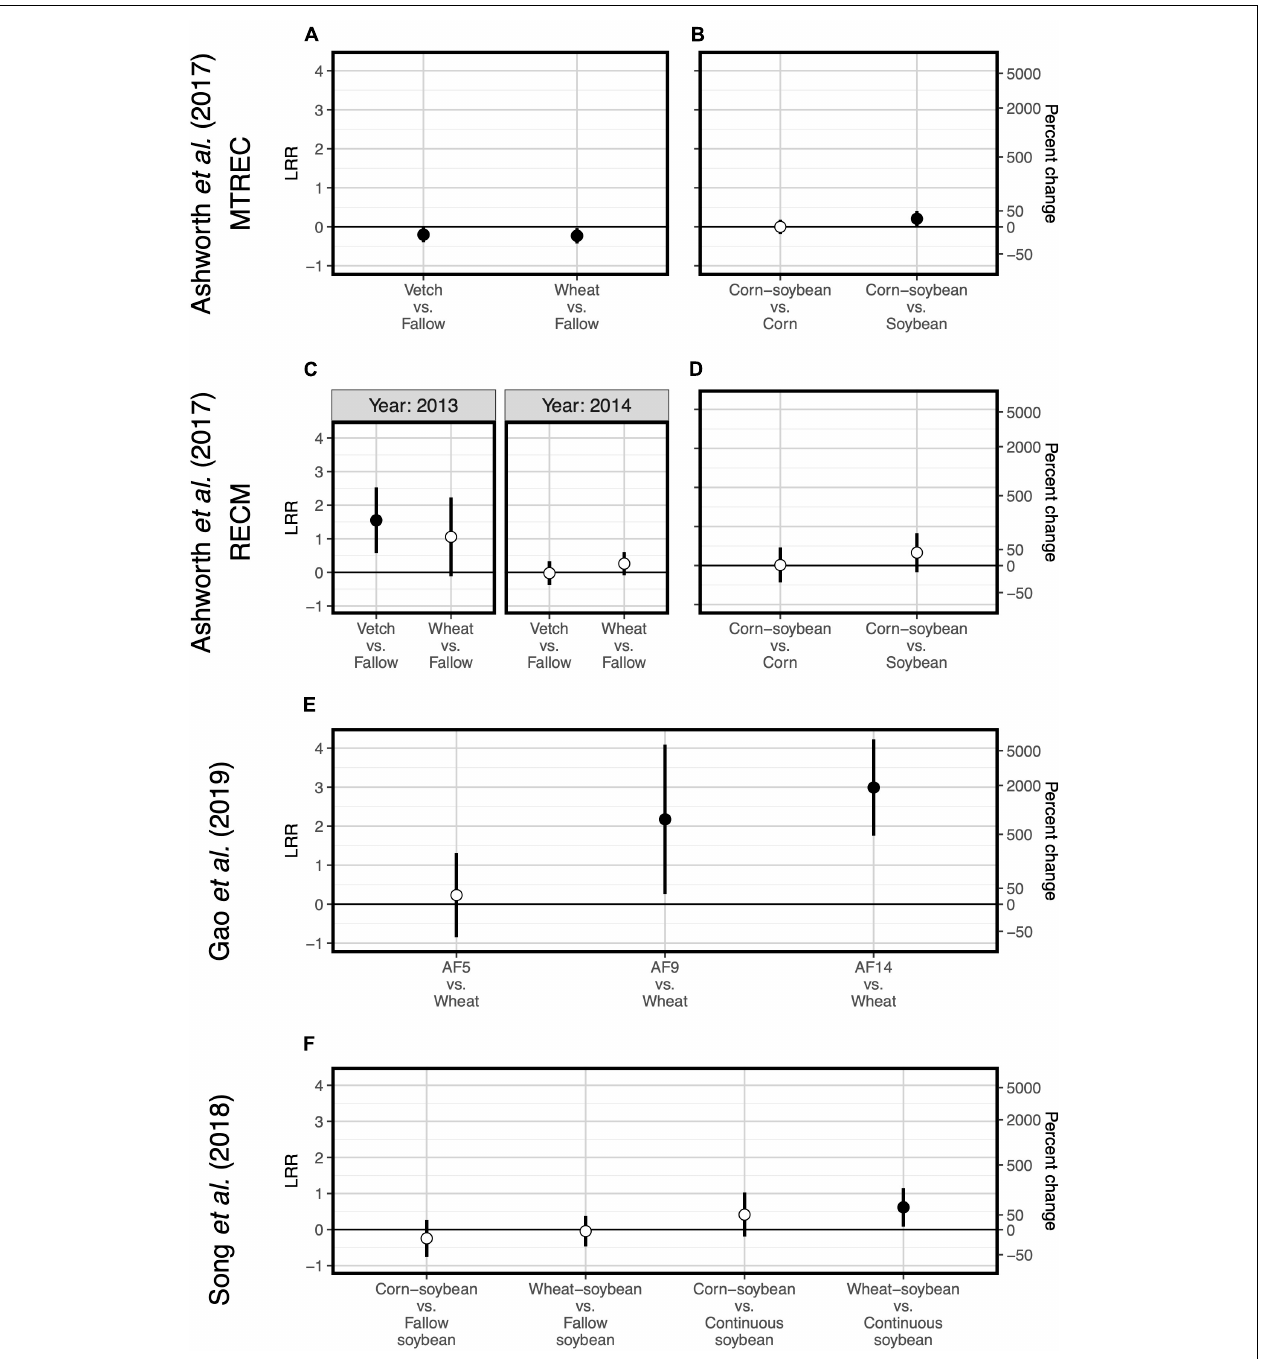
FIGURE 1 | Responses of soil bacterial diversity to crop diversification. Three studies are represented: Ashworth et al. (2017) (A–D) , Gao et al. (2019) (E) , and Song et al. (2018) (F) . Responses are shown as log response ratios (LRR) with 95% confidence intervals which account for low sample sizes (Pustejovsky, 2018). Responses are calculated using Inverse Simpson diversity. Open points represent log response ratios whose 95% confidence intervals overlap zero, while solid points represent log response ratios whose 95% confidence intervals do not overlap